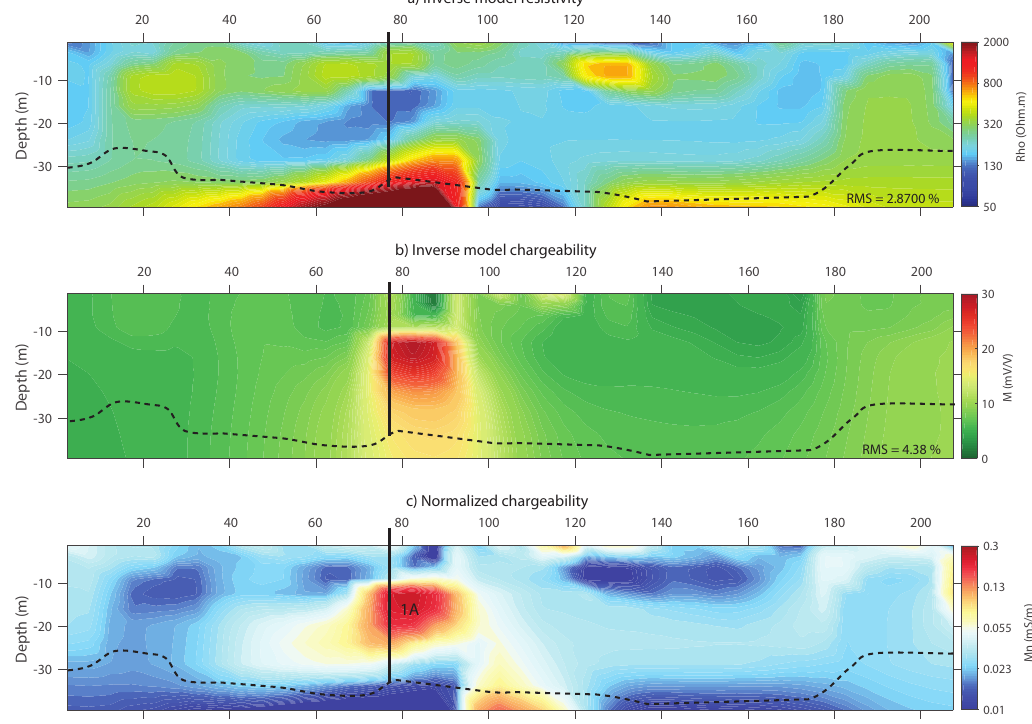
Figure 8. Resistivity, chargeability and normalized chargeability distributions in Profile 1. The straight black line corresponds to the 36 m depth abstraction well which produces CO 2 -rich water. Horizontal positions are given in m . The dashed black line indicates the limit below which the depth of investigation (DOI) value exceeds the trust threshold value of 0.2. The main normalized chargeability anomaly is numbered